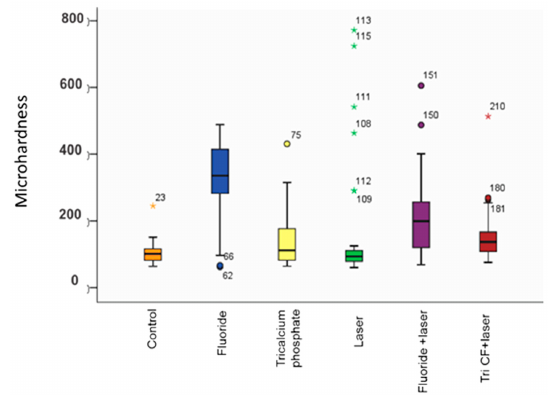
Figure 1. Mean microhardness values between groups ( p < 0.05).